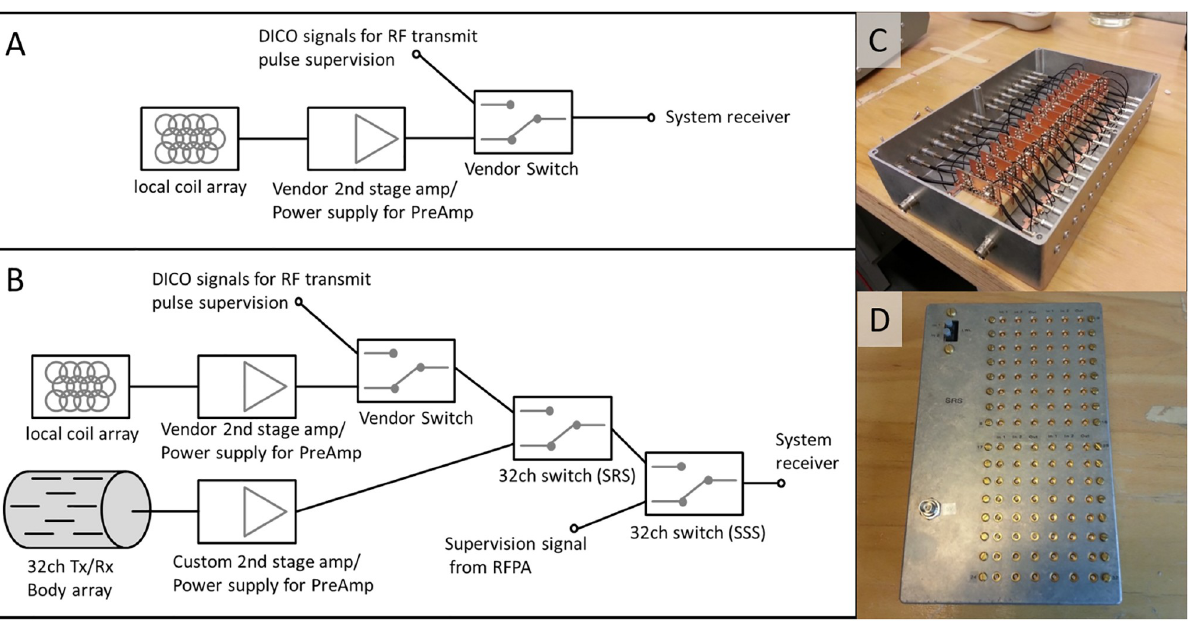
Fig 4. Overview of the receive chain. A) shows the original receive chain as provided by the vendor. B) shows the receive chain after including custom components. C) shows the custom second-stage amplifier with bias tee for the on-coil pre-amps. D) shows one of the 32-channel switches (SRS and